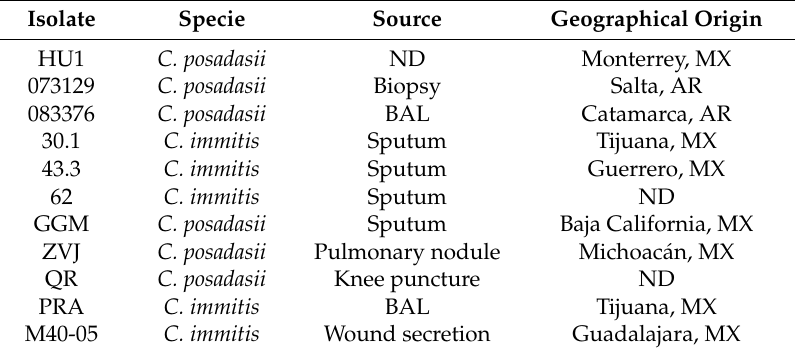
Table 4. Source and geographical origin of Coccidioides spp.